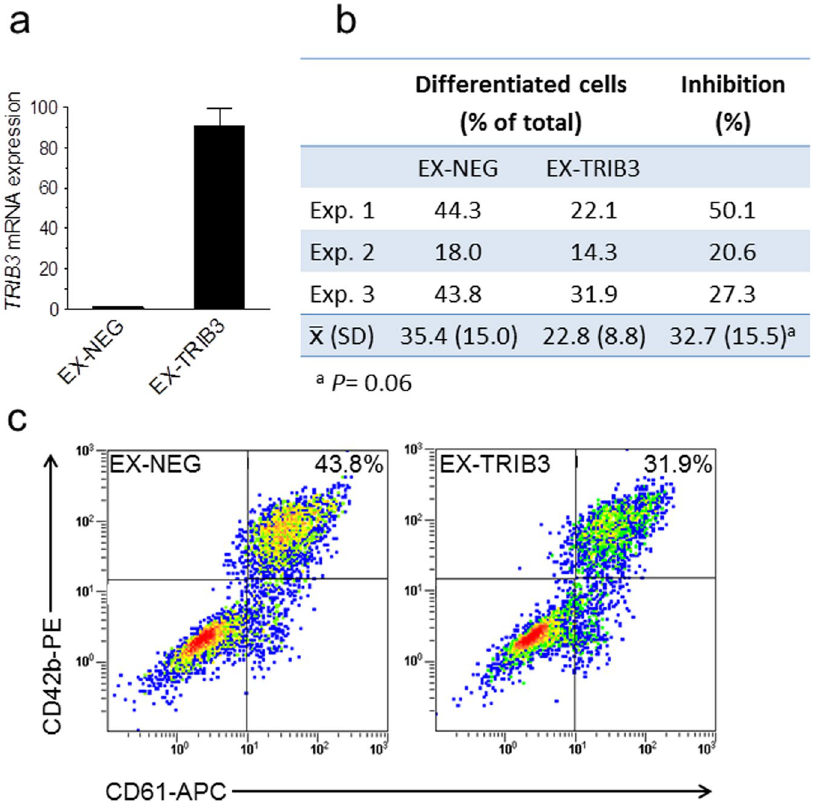
Figure 5. TRIB3 over-expression inhibits the megakaryocytic differentiation of primary haematopoietic cells. Cells transduced with control (EX-NEG) or TRIB3 (EX-TRIB3)-expressing vectors were cultured for 7 days with 1 ng/mL TPO under megakaryocyte differentiation conditions and then analysed for mRNA and surface marker expression. ( a ) TRIB3 mRNA levels are depicted relative to the levels in EX-NEG. Error bars denote SD of technical replicates from one representative experiment (n = 6). ( b,c ) Flow cytometric analysis of differentiation. ( b ) Results of three independent experiments show the proportion of differentiated cells within the eGFP + fraction; the percentage of inhibition was calculated relative to the corresponding values in EX-NEG and then averaged. ( c) Representative density plots corresponding to Exp. 3 display the percentages of differentiated